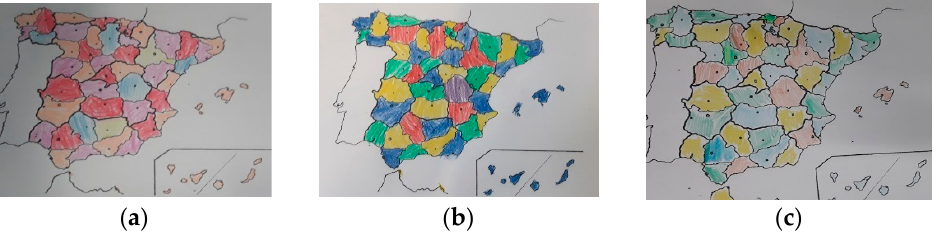
Figure 2. First attempt of coloring the map of Spain. Drawing made by participant: ( a ) A3; ( b ) A6;